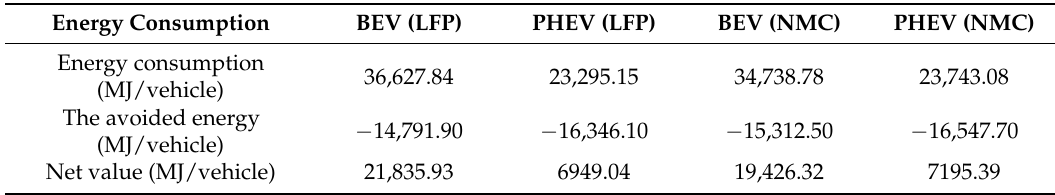
Table 7. Energy consumption in the end-of-life stage.